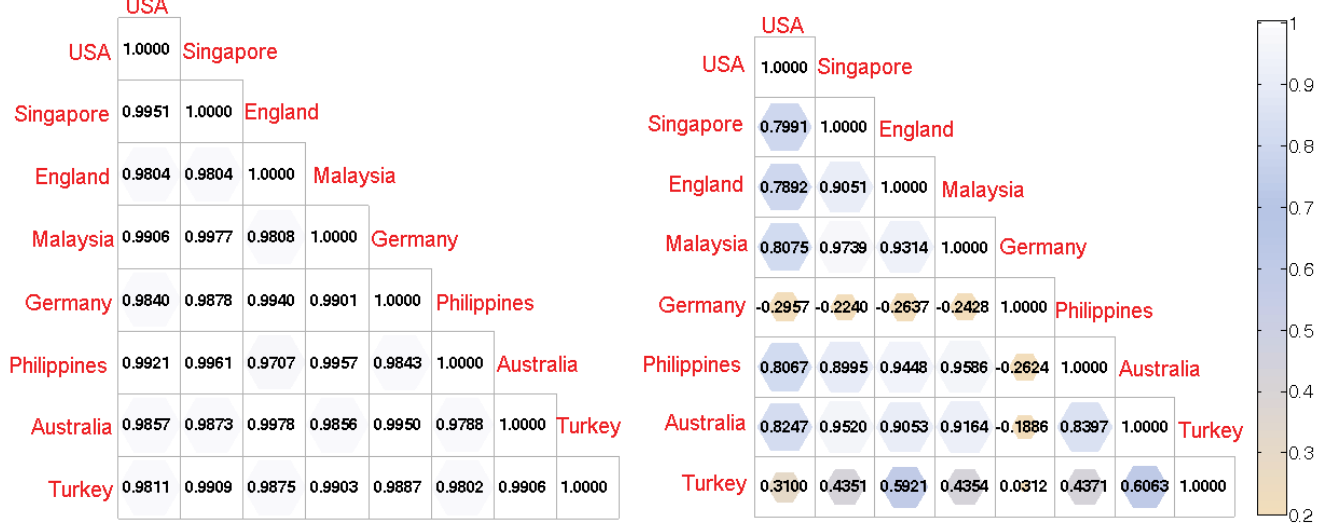
Fig 6. The correlation among information spreading in different regions. There exist a heterogeneous regional responses to events based on the types of events and regional profiles.